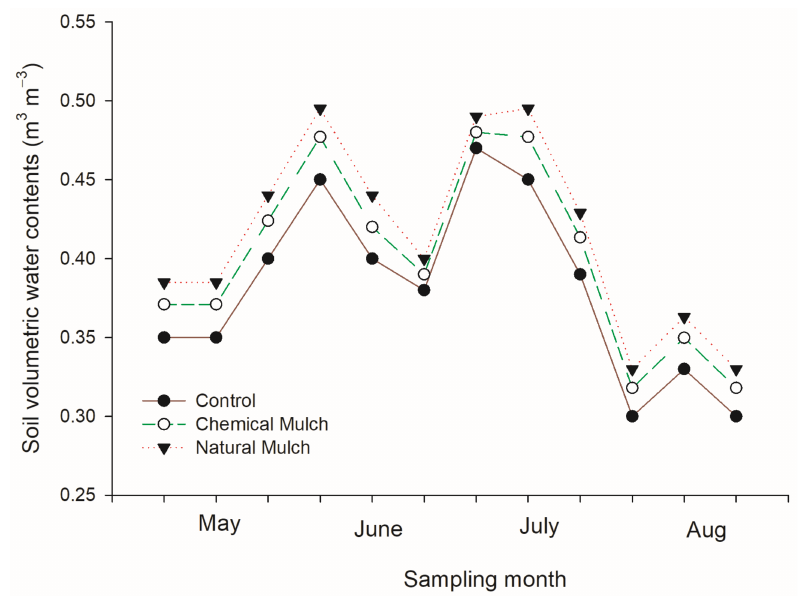
Figure 3. Impact of mulch on soil volumetric water contents during